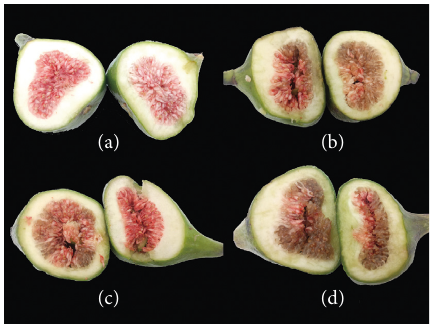
Figure 1: Effects of MA and MA+1-MCP treatments on deteri- oration development in fig fruit after storage for 30 days at − 1 ° C: (a) fresh fruits; (b) MA treatment and stored for 30d; (c) MA+1-MCP treatment and stored for 30d; (d) the control fruit stored for 30d.